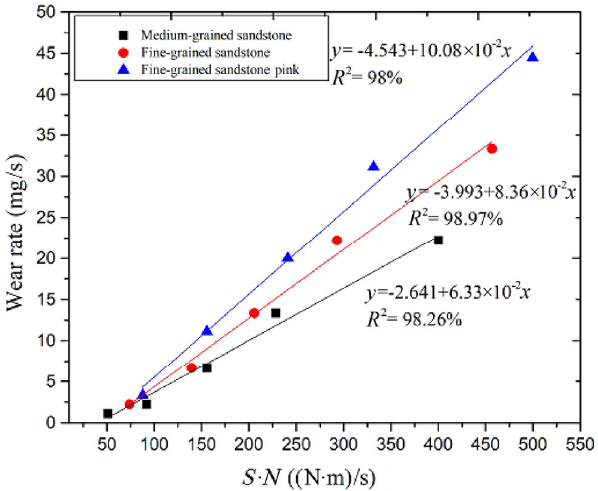
Fig. 8 Wear rate of the WC drill bit as a function of the product of S and N to estimate its wear rate coefficient.